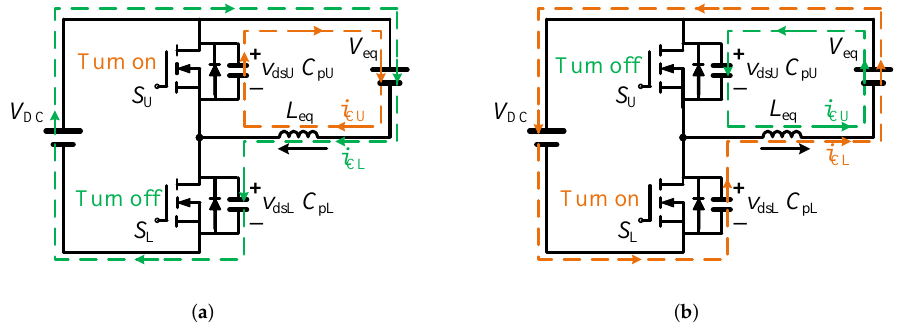
Figure 4. Equivalent circuits for analyzing ZVS: ( a ) for S U turning on and ( b ) for S L turning on. The required initial directions of currents to achieve ZVS are also shown in the